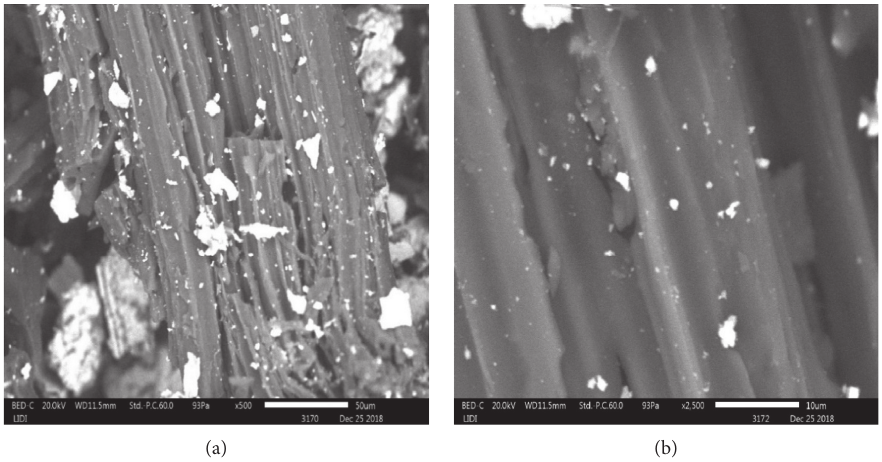
Figure 4: SEM image of (a) BC-0 and (b) BC-SO